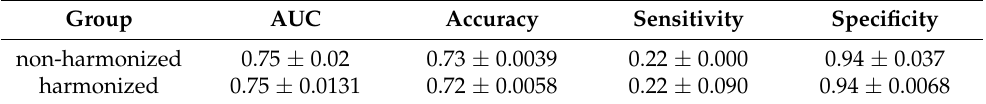
Table 6. Results for a k-fold cross validation using the hybrid-descriptive inferential method. Group AUC Accuracy Sensitivity Specificity Table 7. Results for a k-fold stratified cross validation using the hybrid-descriptive inferential method. Group AUC Accuracy Sensitivity